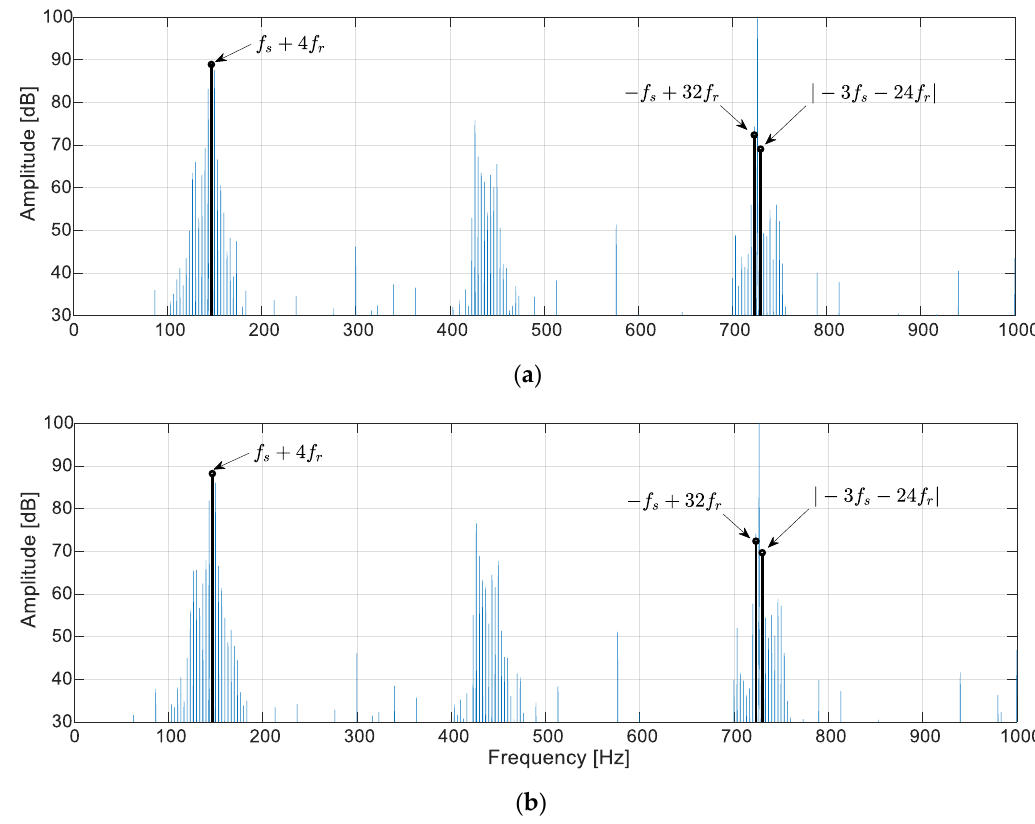
Figure 12. ZSC spectrum of motor with broken rotor cage bars for the stator winding connection: ( a )